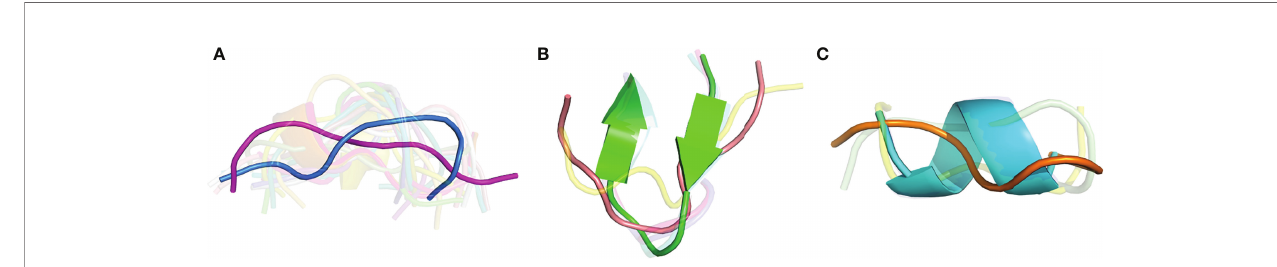
FIGURE 10 | Structural variability of three peptide epitopes. Superposed structures of shared peptide residues from antibody-bound complexes for (A) Cluster 2, HIV fusion peptide (19 structures, 9 residues; AVGIGAVF), (B) Cluster 3, HCV E2 AS412 (7 structures, 9 residues; LINTNGSWH), and (C) Cluster 6, HIV Env MPER (5 structures, 6 residues; LELDKWA). For clarity, peptide structures are shown in semi-transparent cartoon representation, except for representative peptides from PDBs (A) 6PDU (blue) and 6NCP (magenta) (3.26 Å backbone RMSD), (B) 4DGY (green) and 4XVJ (salmon) (3.09 Å backbone RMSD), and (C) 1TJI (orange) and 5DD0 (cyan) (3.03 Å